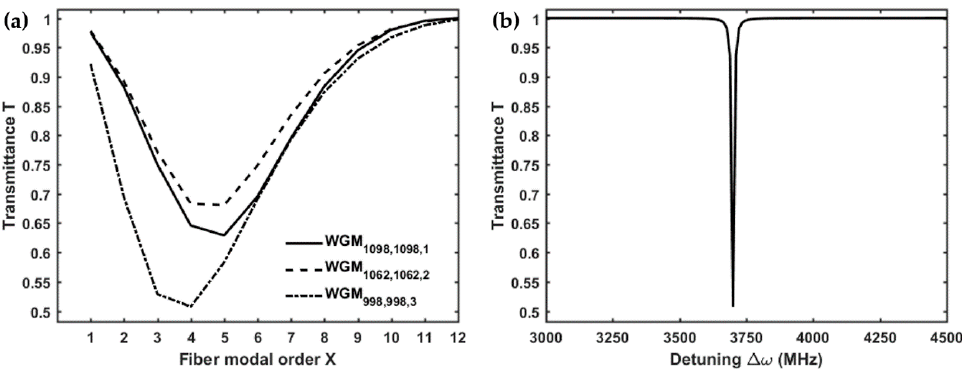
Figure 5. ( a ) Transmitted power of the microbubble-based setup, calculated for three resonant WGM l , m , n , as a function of the modal order X of the LP 0, X cladding modes, with a gap g = 0 nm; ( b ) transmission of the WGM 998,998,3 , excited by the LP 0,4 , as a function of the detuning ∆ ω , with a gap g = 0 nm; microbubble-based